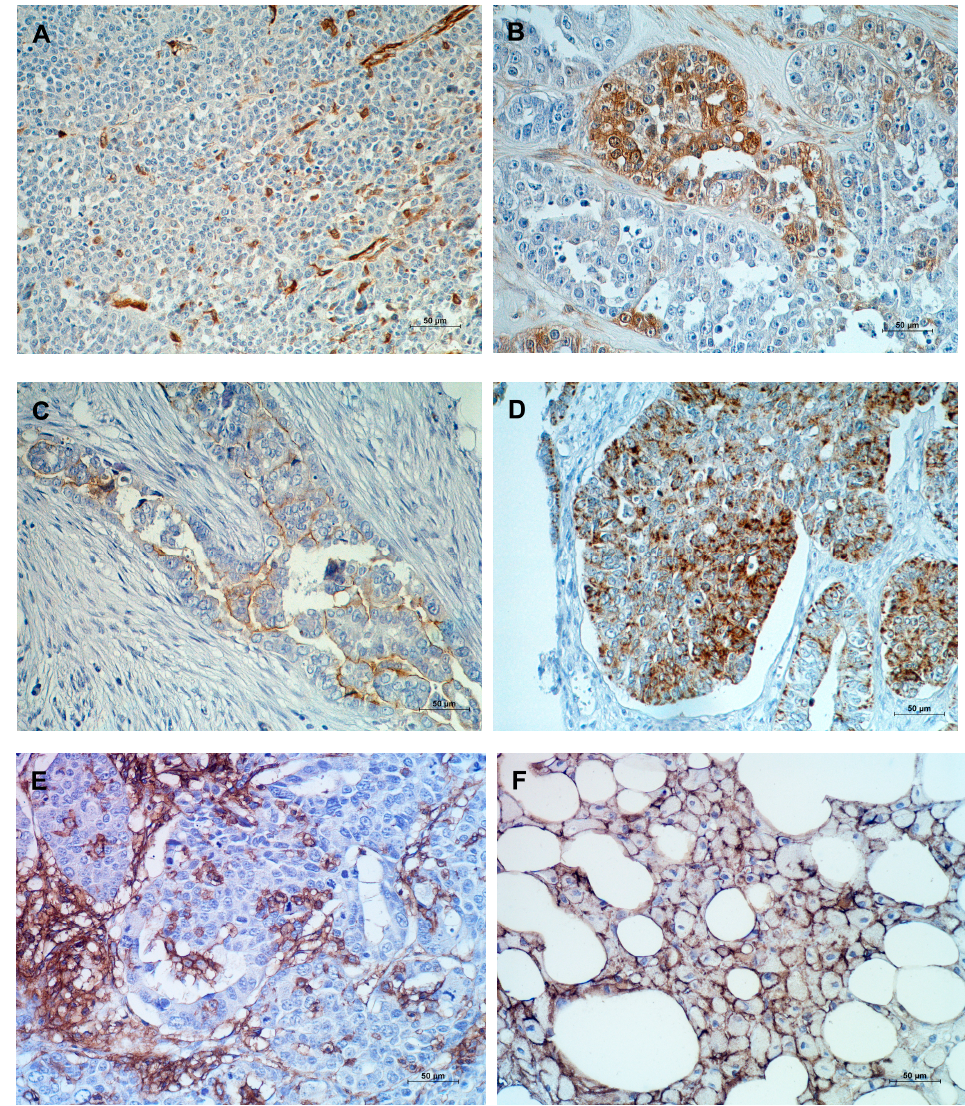
Figure 1. Immunohistochemical expression of ( A ) ALDH1A1—in the cytoplasm of individual cancer cells, ( B ) ALDH1A1—in the cytoplasm of small groups of cancer cells, ( C ) CD133—in the apical cell surface of the tumor cells, ( D ) CD133—in the cytoplasm of the tumor cells, ( E ) CD44—in the cytoplasm and membranes of tumor cells, and ( F ) CD44—in the membranes of tumor cells. The slides were counterstained with hematoxylin. Scale bar = 50 μ m.